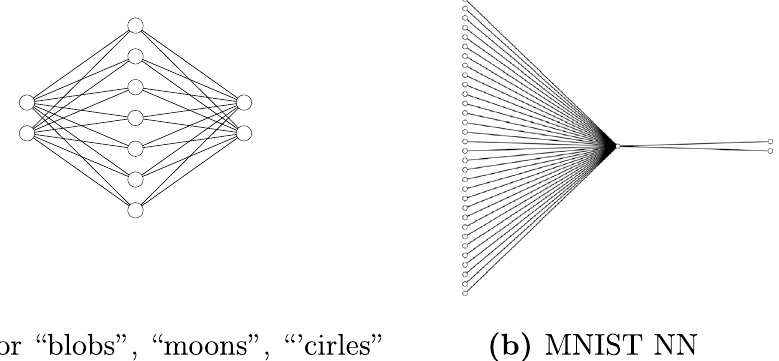
Figure 4. Architecture for the classical neural networks used controls. For ( a ) the left layer is the 2D input and for ( b ) the left layer is the 1024 values from the padded MNIST grayscale images. While the spatial classifier has seven in the hidden layer, the MNIST classifier has only one. The number of nodes is set such that they can be compared to the variational quantum circuits, VQCs, fairly. The right layers have two nodes each, since both tasks are binary classifications. After being normalized by the log-loss function, the output is a vector of the probability of being in each class given the input. For the sake of readability, only 32 of the 1024 input nodes are shown for the MNIST NN.